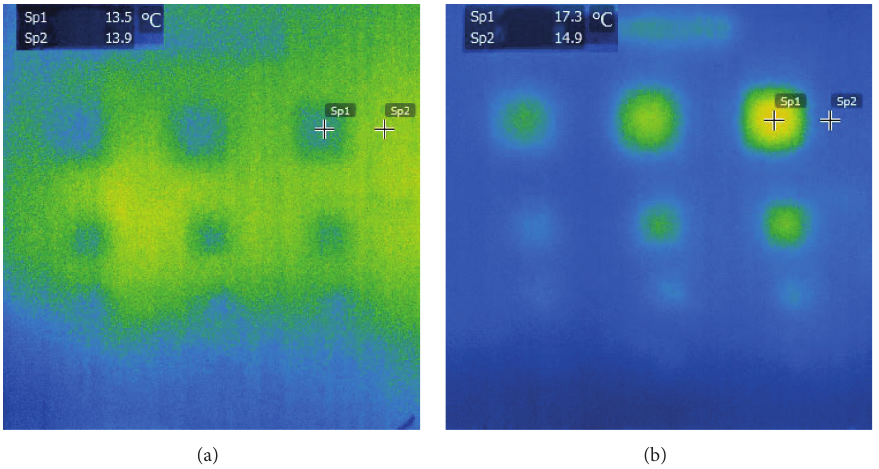
Figure 2: Position of the heat source (a) in the opposite face and (b) in the same face of the camera.